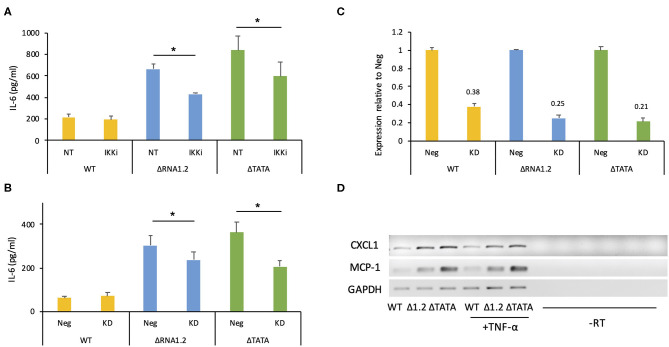
IL-6 secretion by RNA1.2 mutant-infected cells after NF-κB inhibition or TPRG1L knockdown. (A) HFFF2 cells were mock-infected or infected with WT, ΔRNA1.2 or ΔTATA at MOI = 5. At 72 h p.i., the cells were incubated with fresh medium lacking (NT) or containing IKKα-and-IKKβ inhibitor BMS-345541 (IKKi) for a further 6 h. The medium was harvested, and secreted IL-6 was analyzed by ELISA. (B) Immortalized HFT cells were transduced with lentiviruses encoding a non-targeting shRNA negative control (Neg) or a TPRG1L-targeting shRNA (KD). After the establishment of stably expressing cell lines, the cells were infected with WT, ΔRNA1.2 or ΔTATA at MOI = 5. The cells were incubated with fresh medium between 72 and 78 h p.i., which was then harvested and analyzed for secreted IL-6 by ELISA. RNA was also isolated at 78 h p.i. and analyzed by RT-qPCR in (C). (C) Expression of TPRG1L mRNA in knockdown samples calculated relative to that of Neg samples. Data from four independent experiments are shown in each of (A–C). The error bars denote standard error values, and significant differences are marked by asterisks (p < 0.003, paired t-test; p < 0.05, Wilcoxon matched-pairs signed rank test). (D) MCP-1 and CXCL1 transcript levels were monitored during infection of HFFF2 cells with WT, ΔRNA1.2 or ΔTATA at MOI = 5. At 72 h p.i., the cells were incubated with fresh medium lacking or containing TNF-α for an additional 6 h. RNA was then harvested and analyzed by RT-PCR. The data are representative of three experiments.